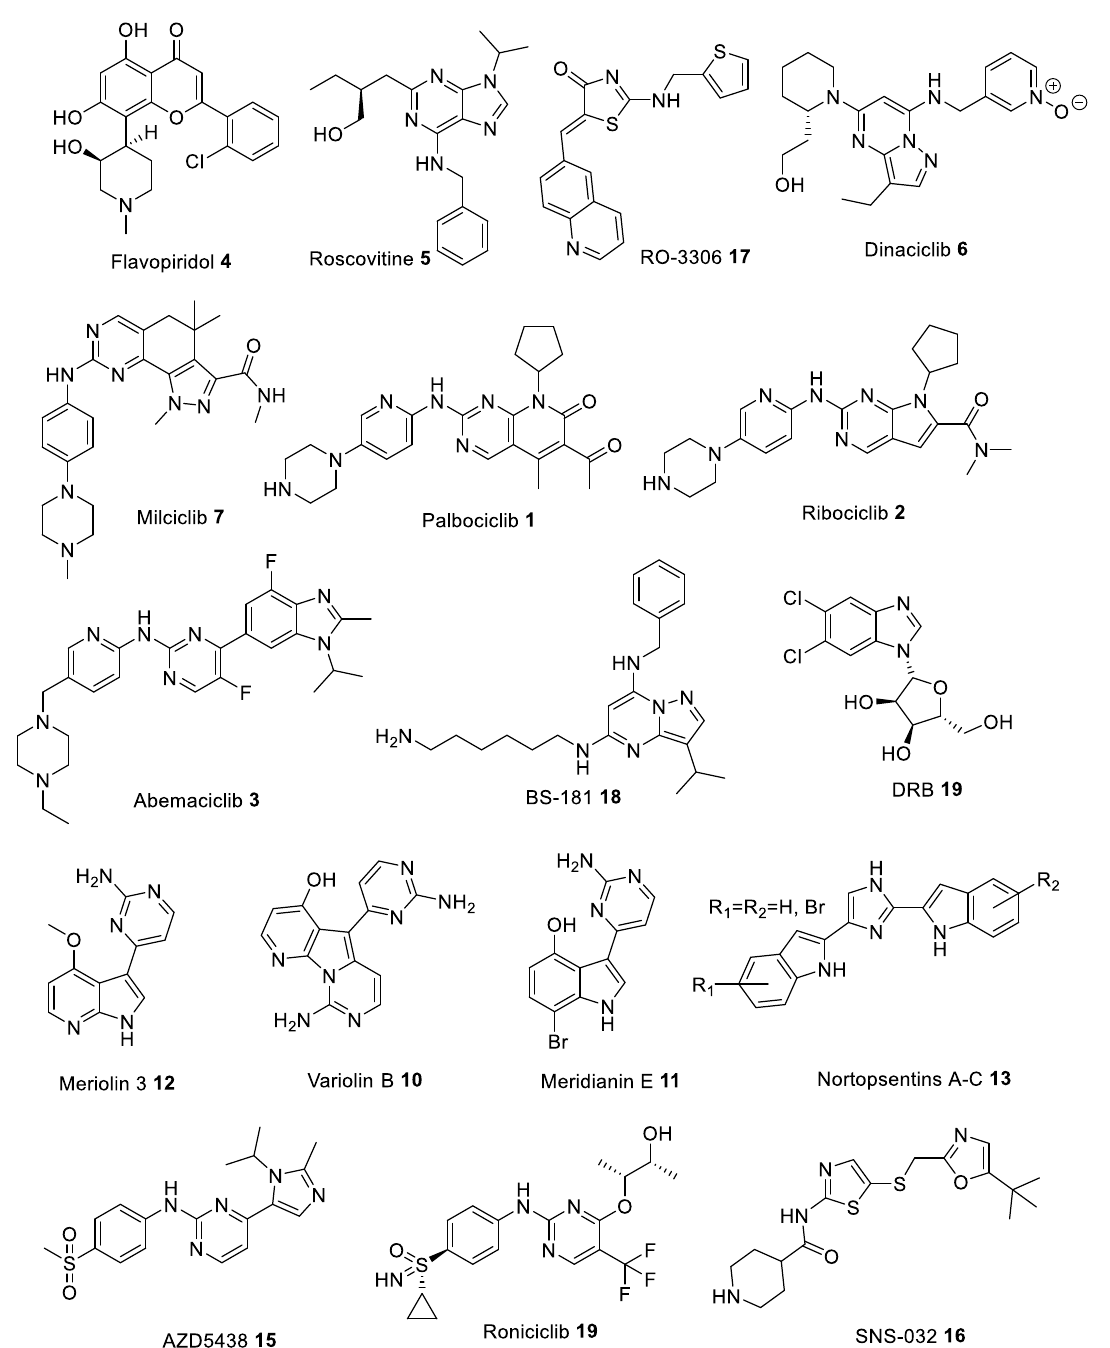
Figure 3. Chemical structures of some of the most studied type I cyclin-dependent kinase (CDK) inhibitors. Roscovitine (Seliciclib) 5 (Figure 3), one of the best known CDK inhibitors, is active against CDK2, CDK5, CDK7 and CDK9 (Table 1). This compound is, by far, the most ef- fective inhibitor of CDK5/p25 (IC 50 = 160 nM [17]), as shown by numerous studies using this compound as a potential drug against cancer, neurodegenerative or viral diseases, inflammation, polycystic kidney disease (PKD) and glomerulonephritis (Table 2) [18–22]. are not that promising [23].